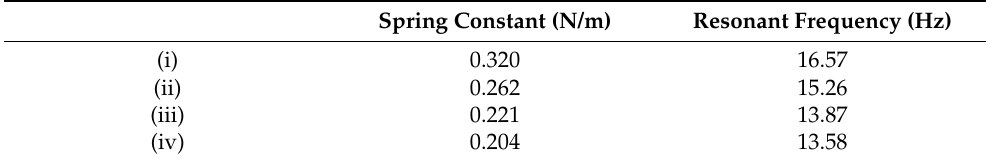
Table 1. Simulation characteristics of each force plate .